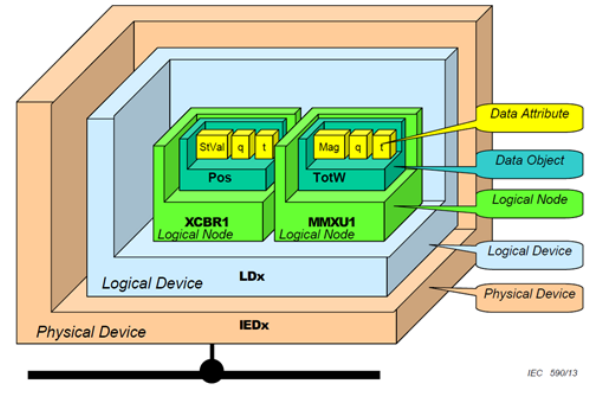
Figure 3. IEC 61850 Data Modeling